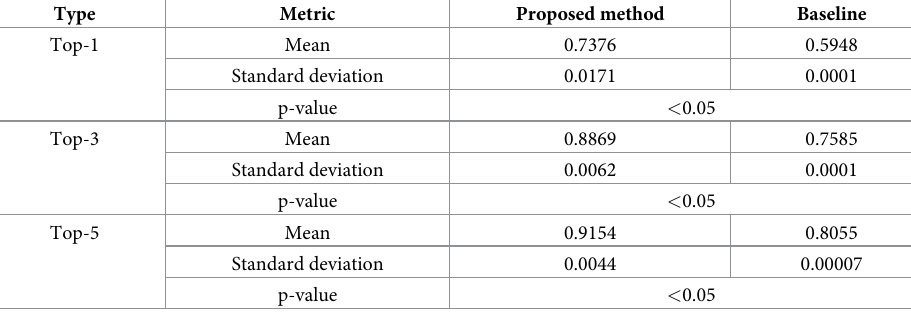
Table 5. Test results for the proposed method and baseline method.